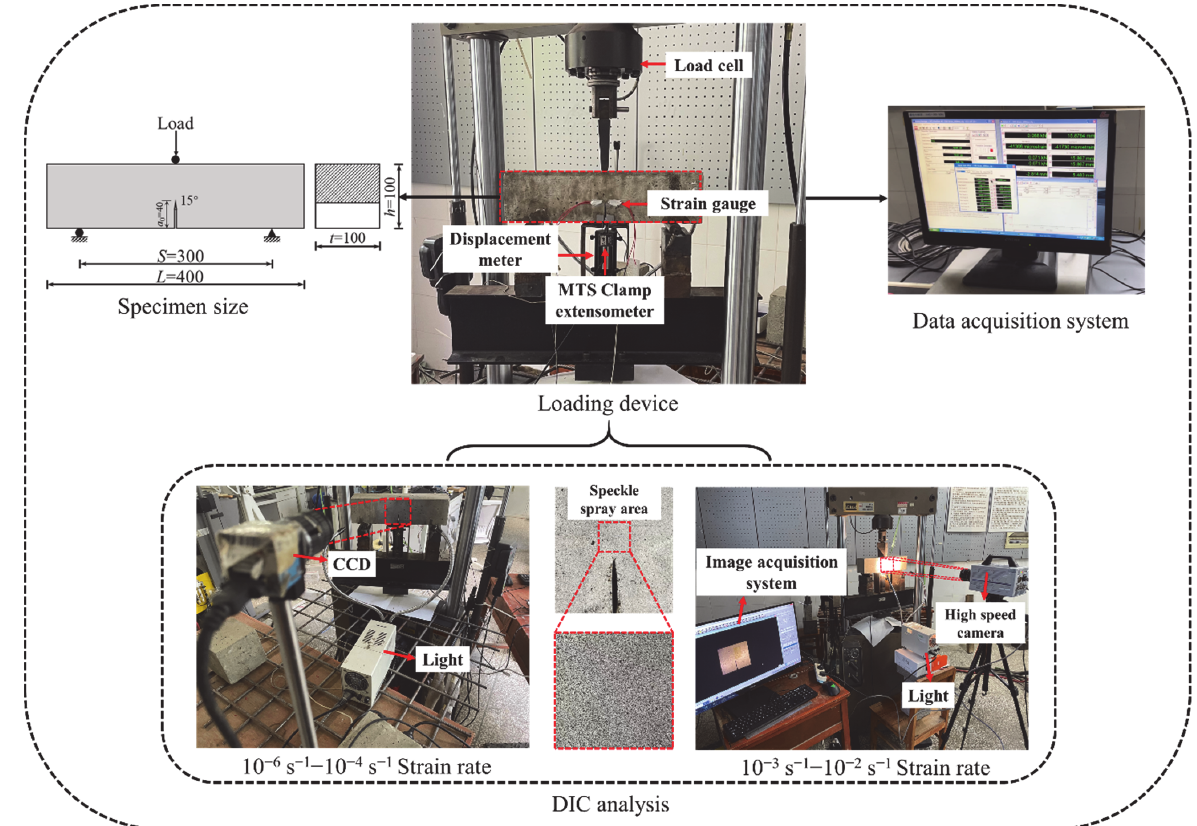
Figure 3. Diagram of the test device.